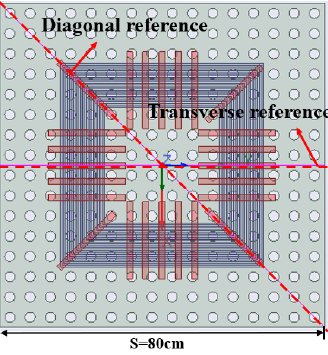
Figure 9. Schematic diagram of transverse and diagonal reference lines of the mesh aluminium plate in the wireless transmission system.